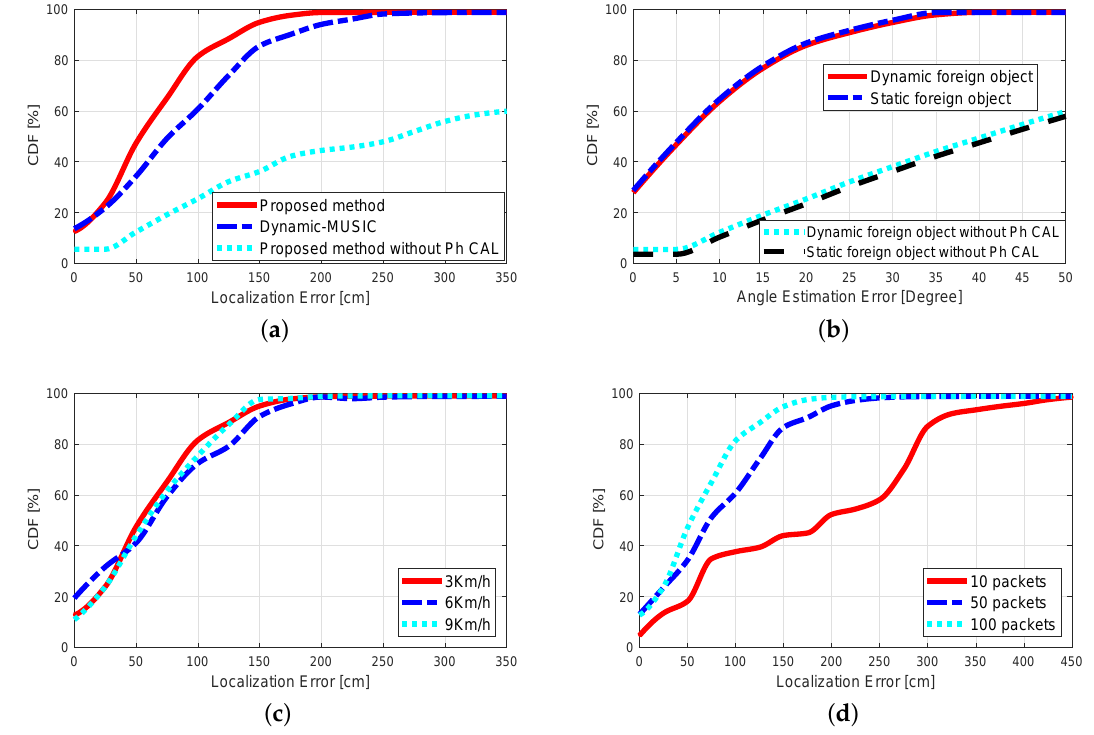
Figure 14. Experimental results of foreign object localization performance. ( a ) Comparison with Other Algorithms. ( b ) Performance of Angle Estimation. ( c ) Impact of Speed on Localization. ( d ) Impact of Packet Number on